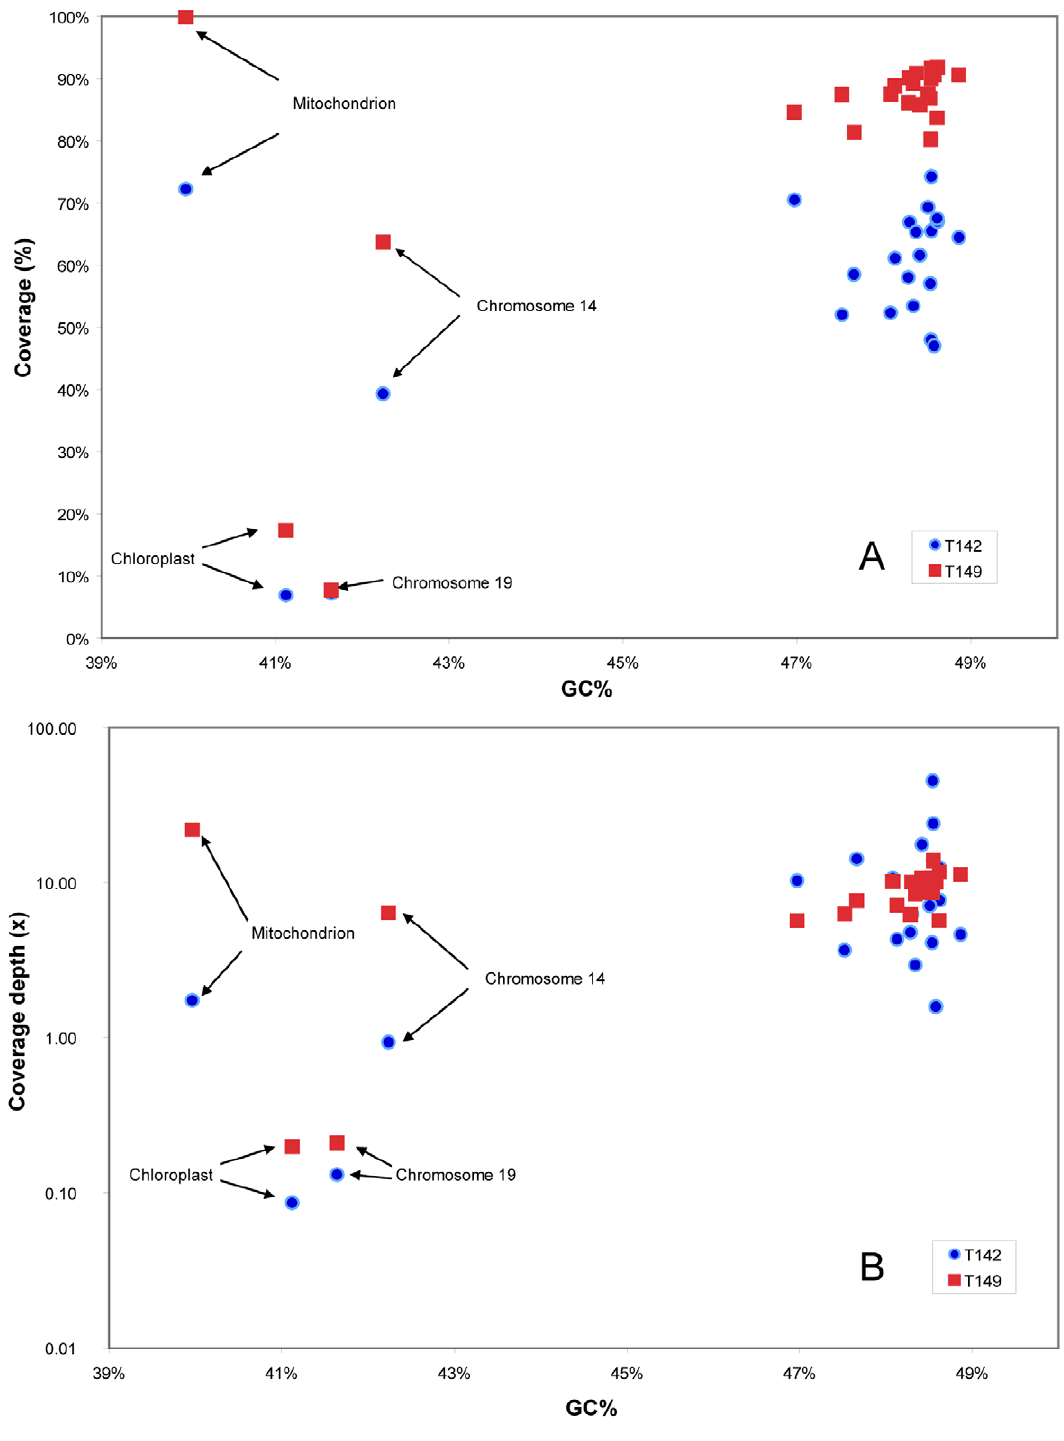
Figure 1. Assembly of metagenomic reads obtained from flow cytometry sorted picoeukaryote samples T142 and T149 from the Chile upwelling to Bathycoccusprasinos RCC1105 genome. (A) Relationship between average coverage fraction (expressed as % of the length of the chromosome covered by at least one read) and GC content for samples T142 and T149 for the 21 draft nuclear chromosomes of B. prasinos RCC1105 as well as the mitochondrion and plastid genomes. (B) Idem for average coverage depth (number of reads at each